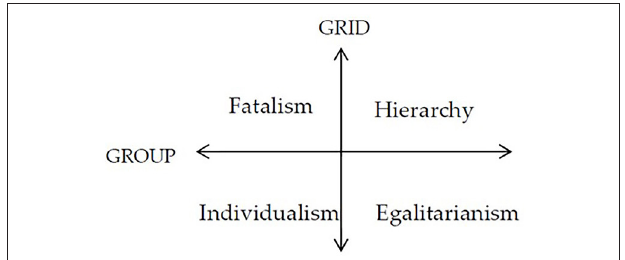
FIGURE 1 | The group-Grid